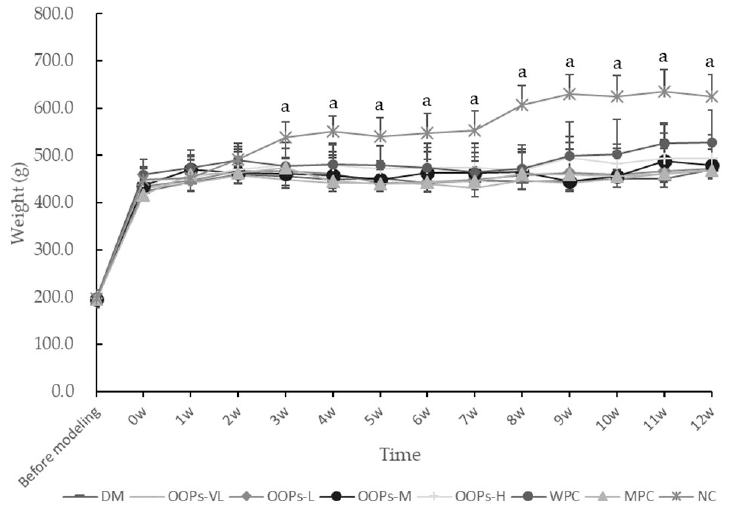
Figure 1. Effect of OOPs on body weight.